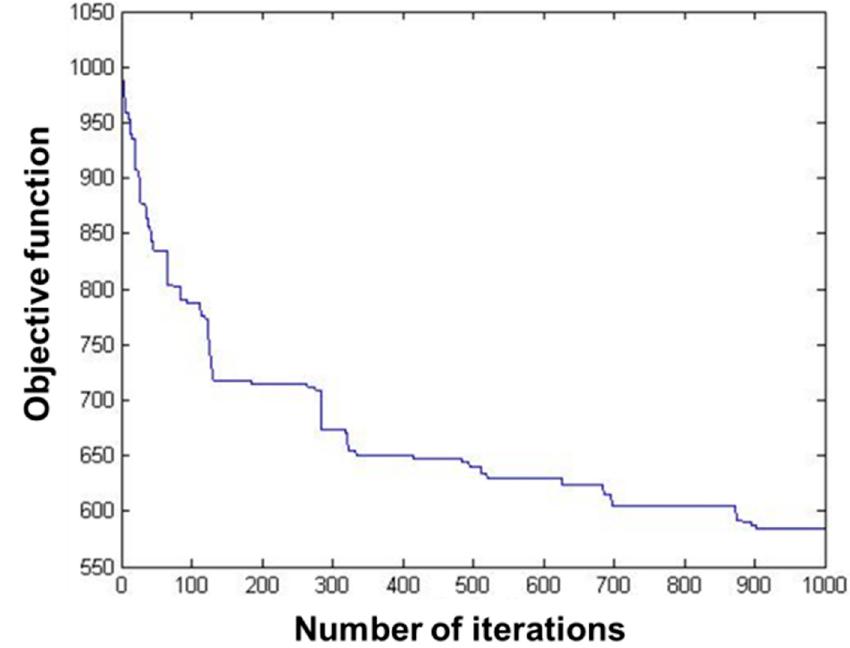
Figure 5. Convergence trajectory of the genetic algorithm.